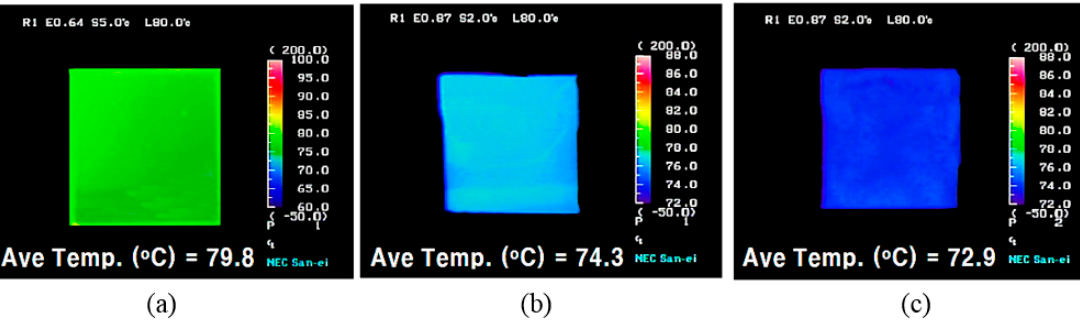
Figure 10. Photographs of the surfaces of the specimens measured by thermal image camera at an atmosphere temperature of 80 °C; ( a ) Uncoated Cu, ( b ) CNT-coated Cu, ( c ) BN-coated Cu.